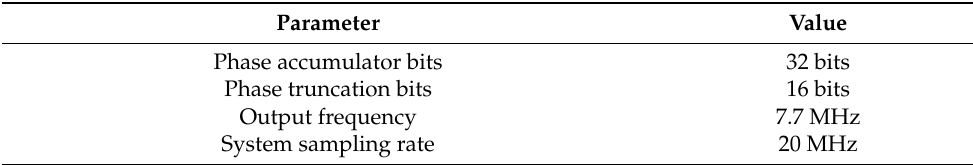
Table 1. Parameter of the direct digital